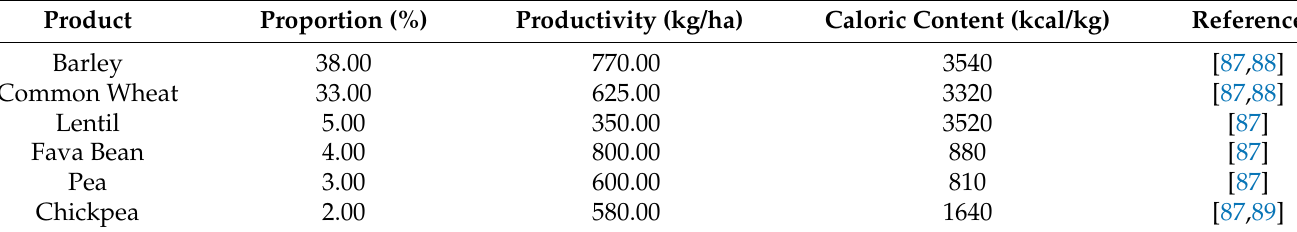
Table 2. Assumed diet characteristics in the research area (based on [79,80,86] adjusted according to isotope-analyses results of